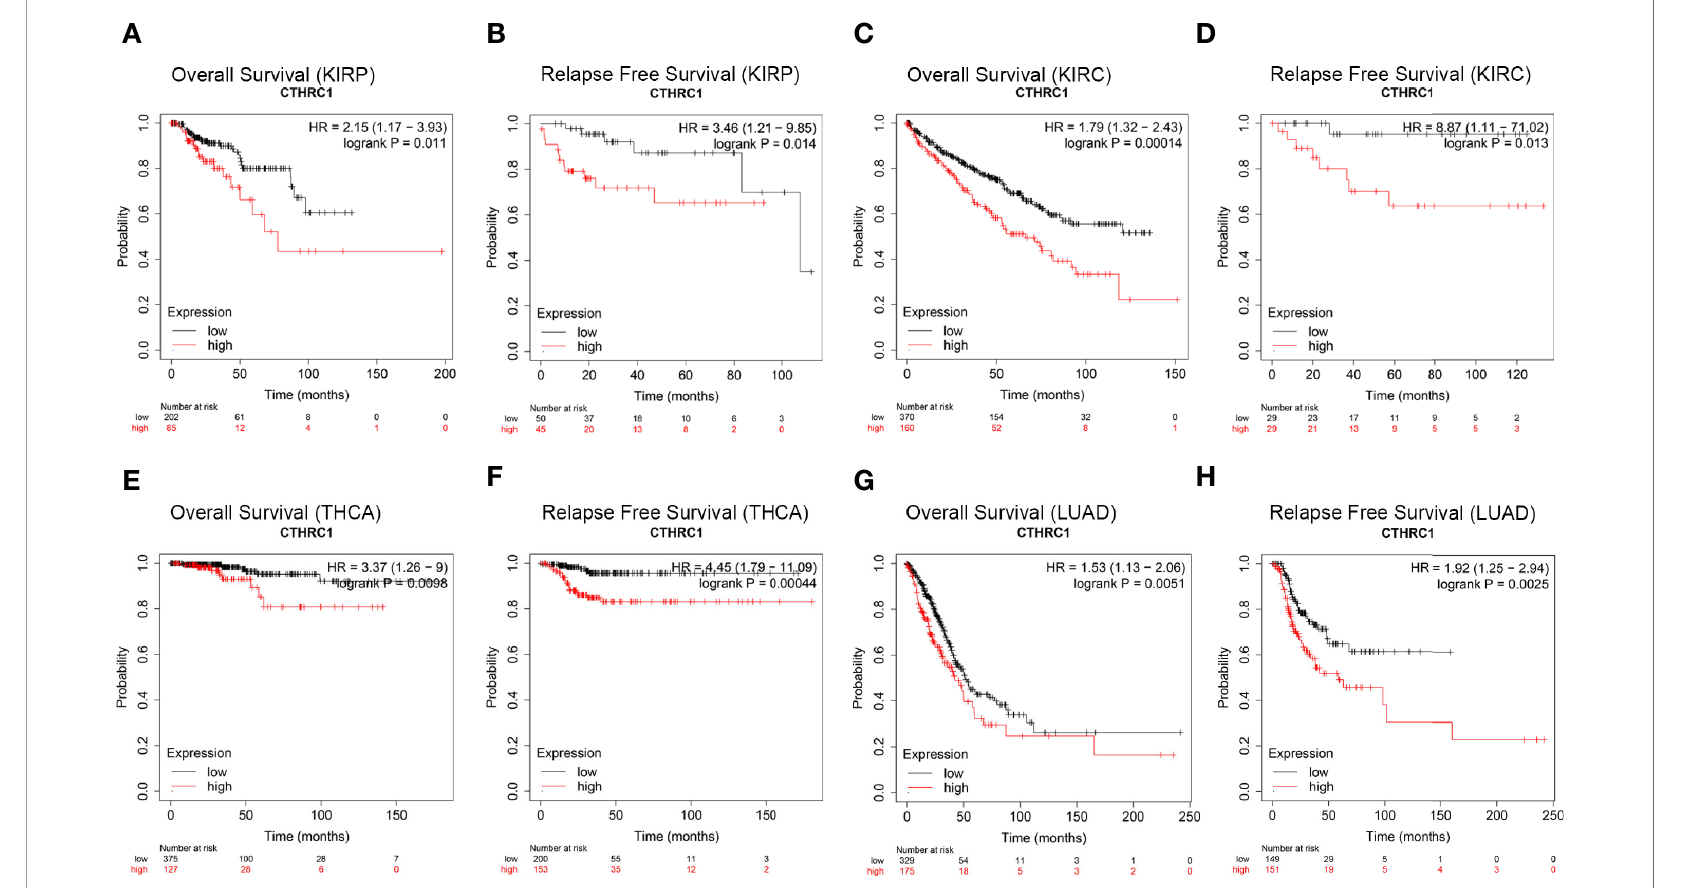
FIGURE 2 | Comparison of Kaplan-Meier survival curves of CTHRC1 high and low expression in different cancers. (A, B) High CTHRC1 expression had poor OS and RFS in KIRP (n=288). (C, D) Upregulated CTHRC1 expression had worse OS and RFS in KIRC (n=530). (E, F) Difference in survival among high and low CTHRC1 levels in THCA (n=502). (G, H) Survival differences of CTHRC1 expression in LUAD